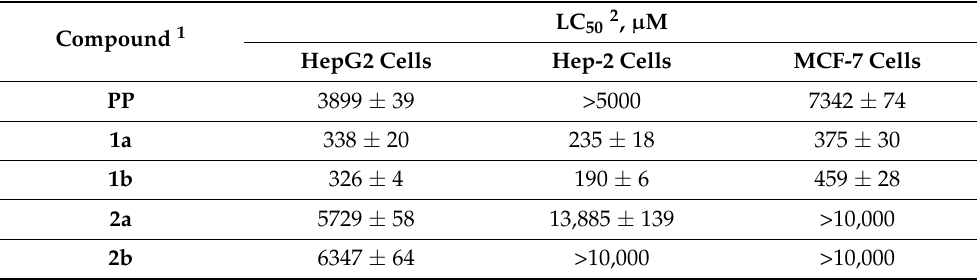
Table 1. The cytotoxicity (LC 50 ) of compounds against HepG2, Hep-2 and MCF-7 cells. The values are the mean of three wells ± standard deviation (SD).